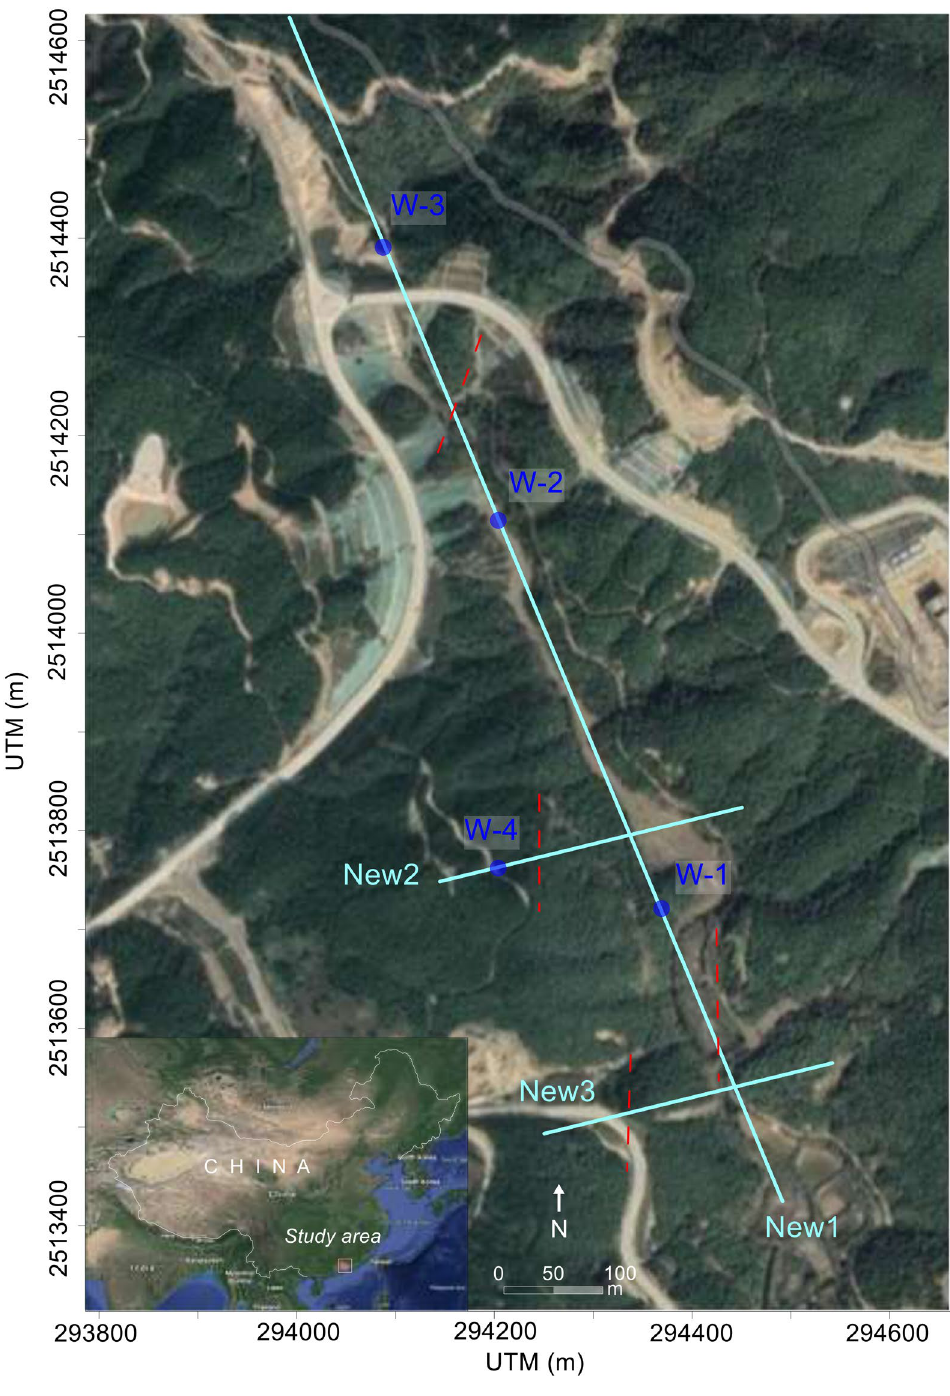
Figure 2. Location of the investigated area, including 3 geophysical profiles New1, New2 and New3 (light blue lines), boreholes W1-4 (blue dots), and the traced faults (red dashed lines in different directions). The map was created on the basis of Google Earth (https:// earth. google. com/) by M. Hasan in the CorelDRAW 12.0 Graphic